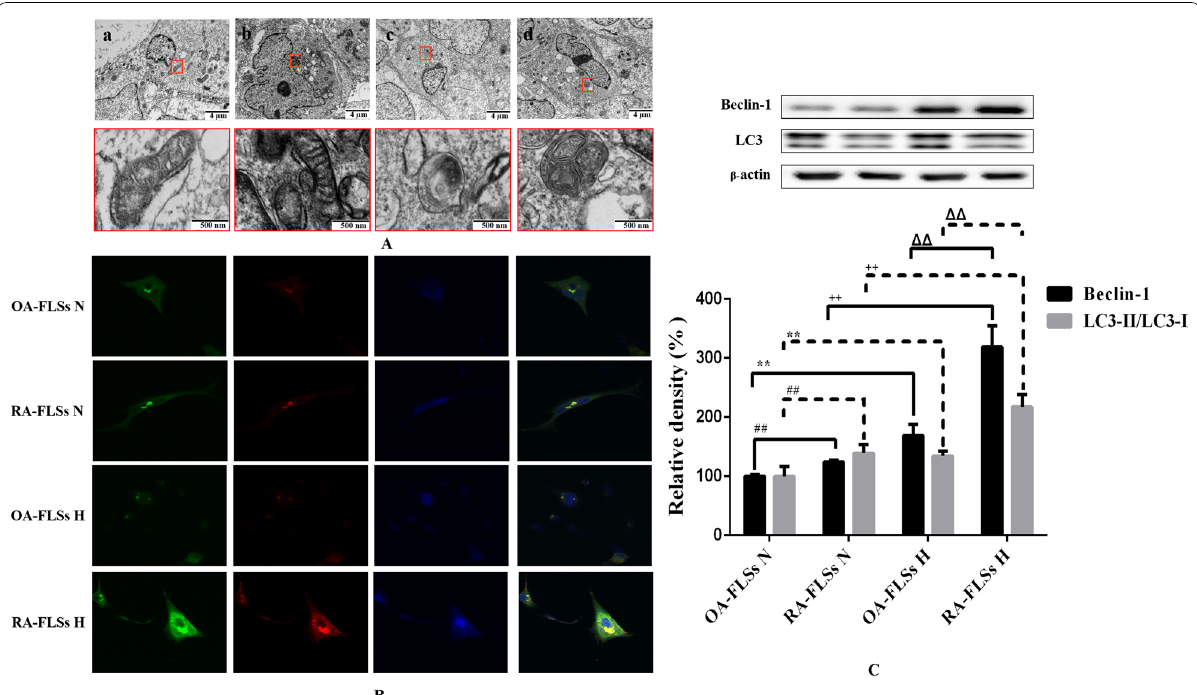
Fig. 3 Effects of hypoxia on the mitophagy of OA-FLSs or RA-FLSs. A After exposed to 21%, 2% O 2 for 24 h, cells were analysed by electron microscopy. B Cells were infected with EGFP-LC3 (Green) for 24 h and then exposed to 21%, 2% O 2 for another 24 h, after that, mitochondria were marked with Mitotracker (Red), Nuclei were stained with DAPI (blue). Representative images were shown. C The expression of Beclin-1 and LC3 was analyzed by Western blot (mean SD, n 6 from three independent experiments). # P < 0.05, ## P < 0.01 represents the comparison between ± = OA-FLSs N and RA-FLSs N; *P < 0.05, **P < 0.01 represents the comparison between OA-FLSs N and OA-FLSs H, + P < 0.05, ++ P < 0.01 represents the comparison between RA-FLSs N and RA-FLSs H, Δ P < 0.05, ΔΔ P < 0.01 represents the comparison between OA-FLSs H and RA-FLSs